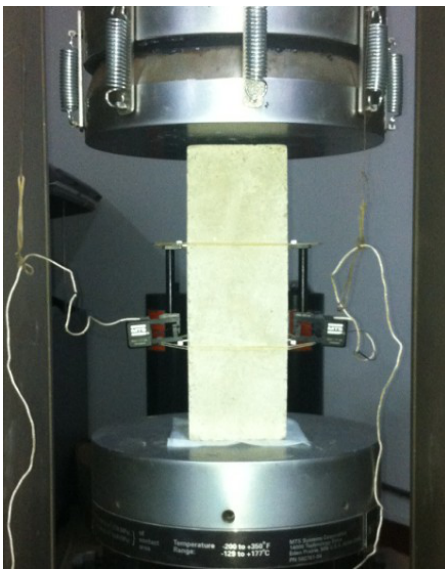
Figure 3. Macro-testing system of uniaxial loading.